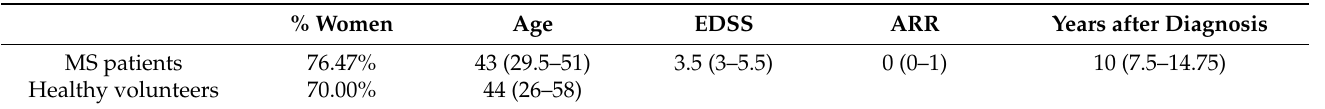
Table 1. Basic information about study groups; EDSS—expanded disability status scale; ARR—annual relapse rate. Values are presented as median,